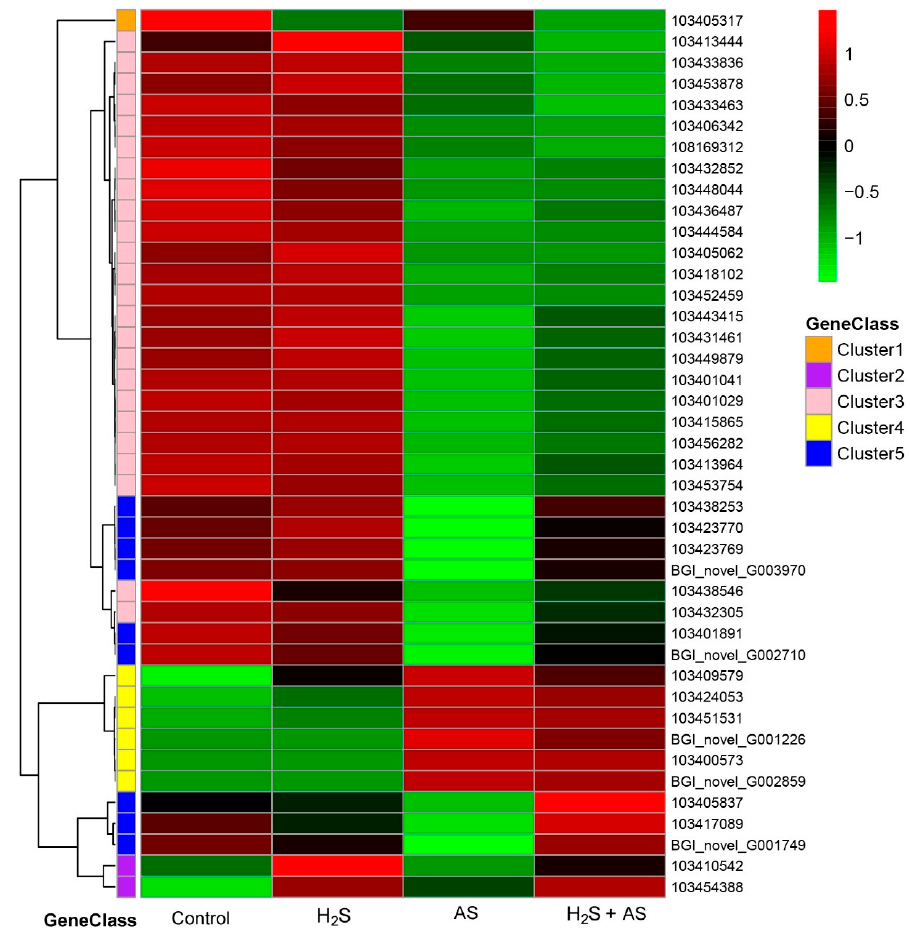
Figure 5. H 2 S specifically induces S-containing compound genes to alleviate alkaline salts in M. hupehensis roots.